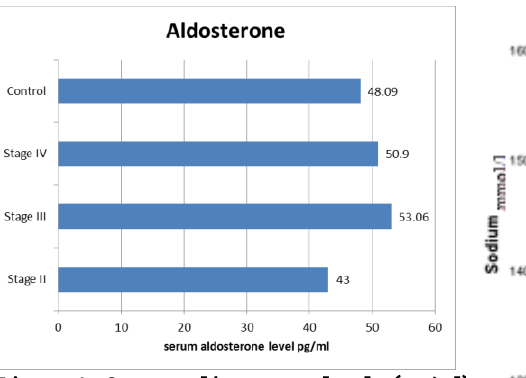
Figure 1. Serum aldosterone levels (pg/ml) among various stages of CKD patients compared to the control group